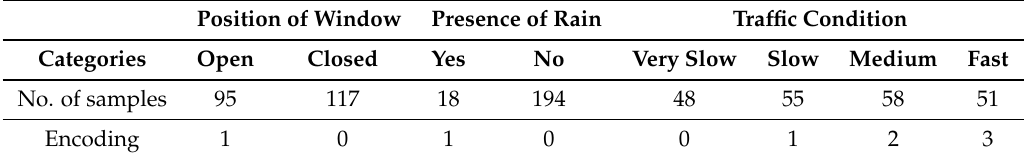
Table 3. Distribution of the 212 measurements by the possible states of each categorical variable. Position of Window Presence of Rain Traffic Condition Categories